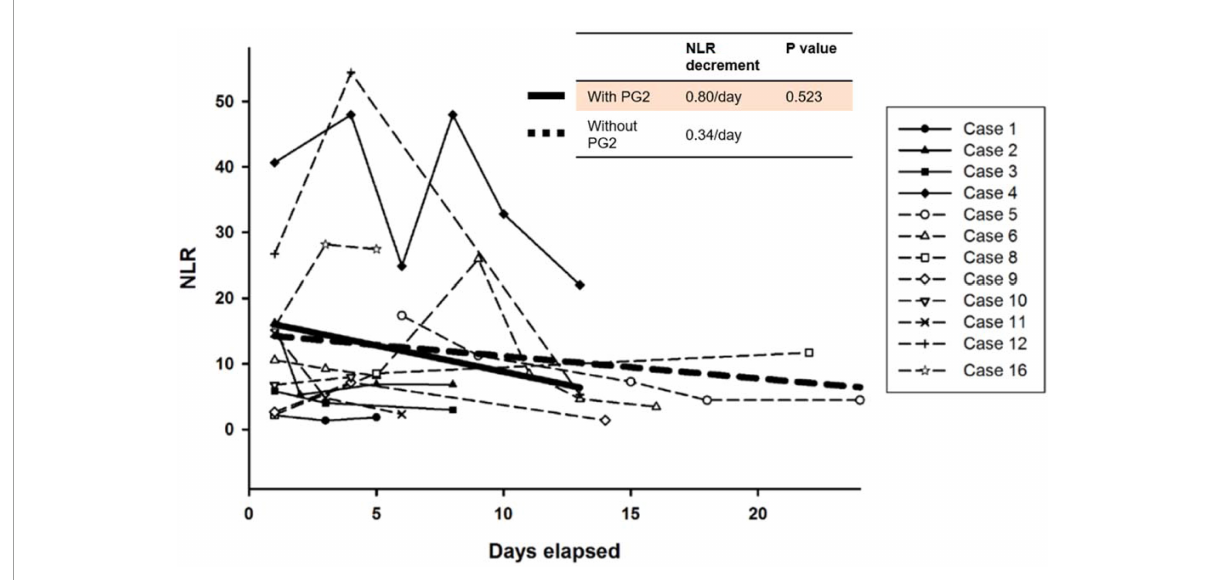
FIGURE2 Time course changes of neutrophil-to-lymphocyte (NLR) ratio in patients with severe COVID-19. The bold straight line indicates estimates of the NLR decrease per day by linear mixed model in patients treated with PG2, whereas the dotted straight line indicates integrated trend in the NLR in patients who were not treated with